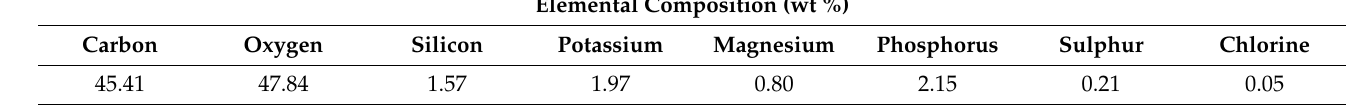
Table 7. Elemental composition of Carnaroli rice bran as determined by Energy dispersive spec- troscopy (EDX; X-max 50 mm 2 probe by Oxford Instrument connected to an EVO MA10 scanning electron microscope by Zeiss) performed on a sample after drying at 45 ◦ C for 6 h in an oven (own